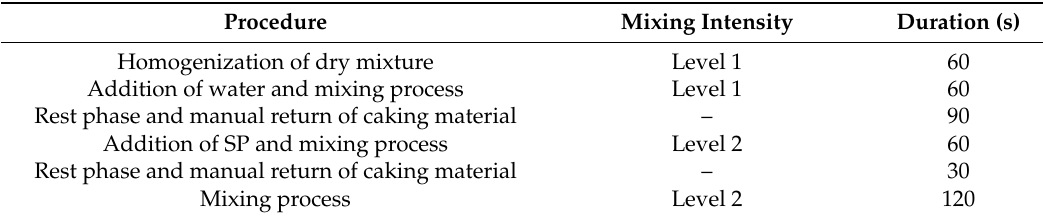
Table 1. Mixing sequence for sample preparation with a mixer according to DIN EN 196-1